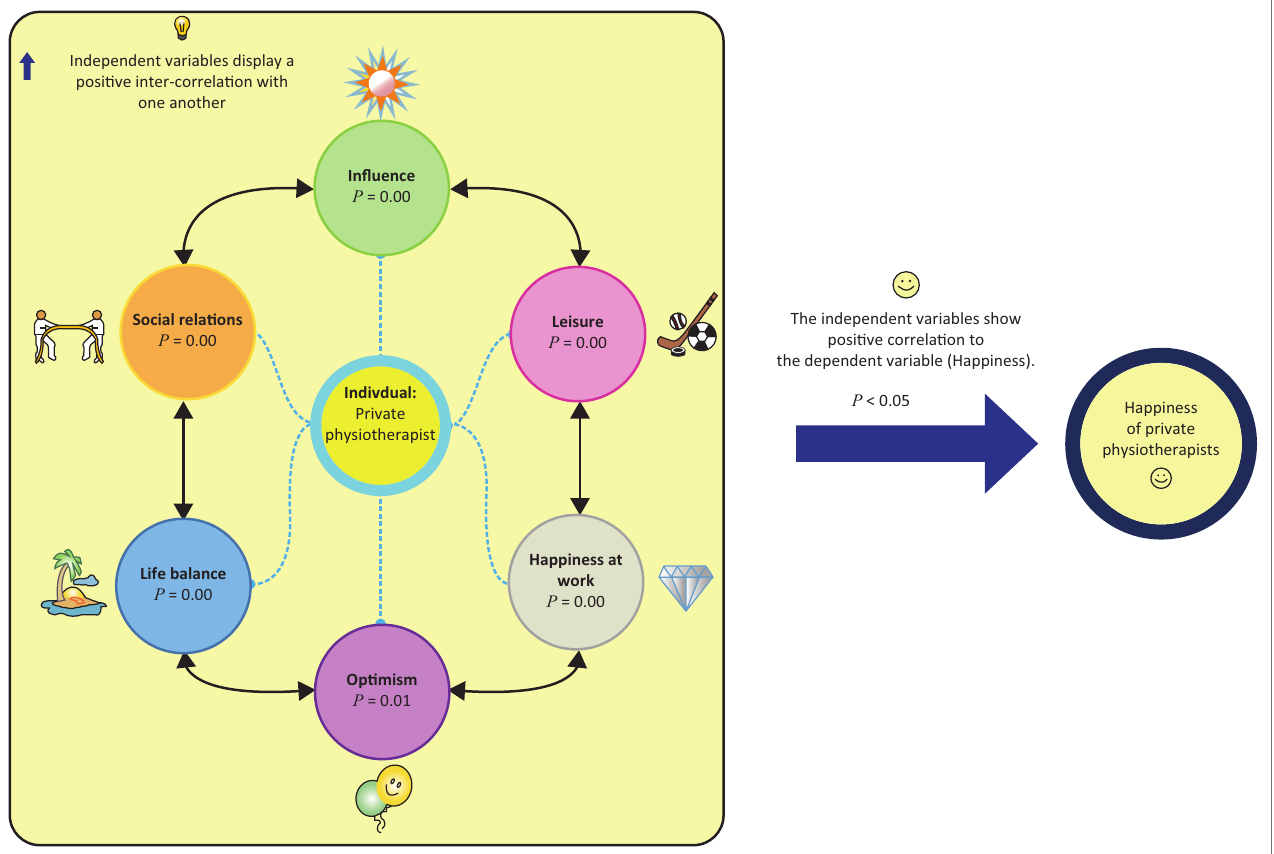
FIGURE 2: Statistical model for enhancing happiness of private physiotherapists in South